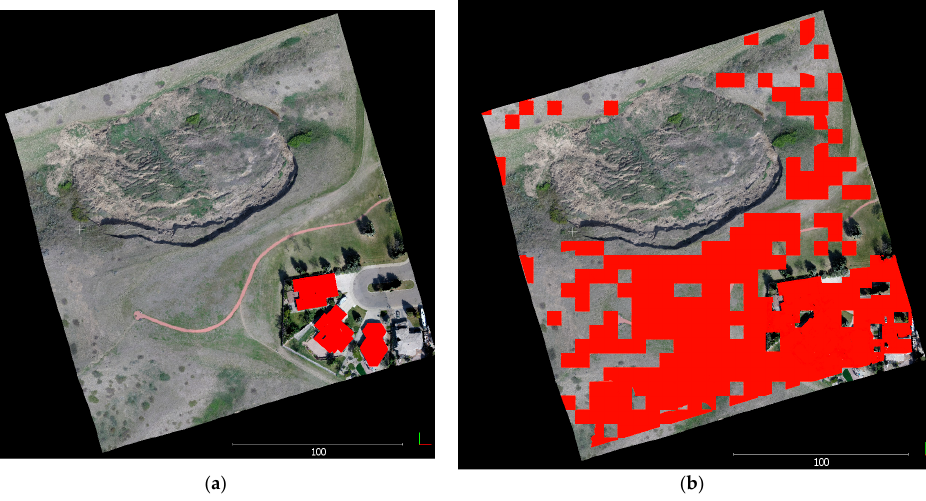
Figure 4. Selected patches used to estimate quantitative quality control overlaid on the point cloud. ( a ) Selected building rooftops; ( b ) selected stable area surfaces.